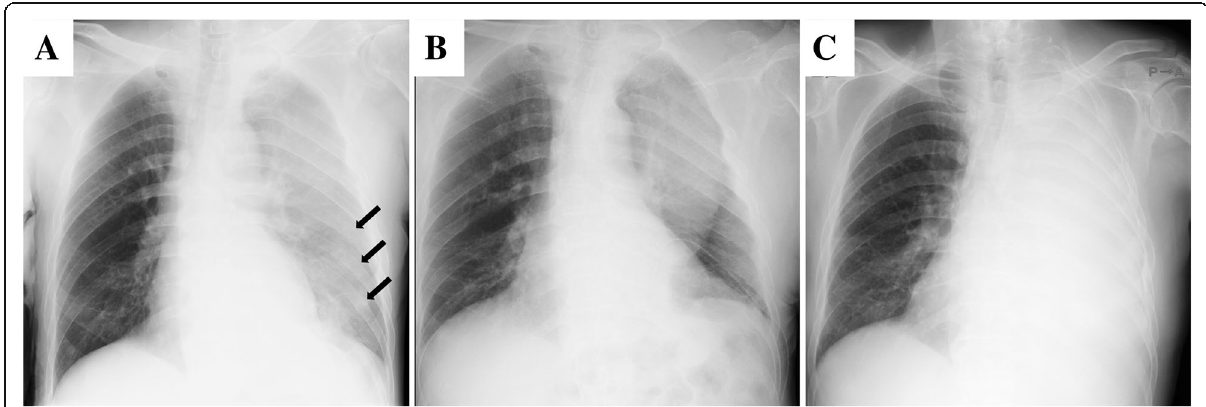
Fig. 1 Chest radiograph showing the left multiple rib fractures (black arrow), a hemothorax, and an extrapleural hematoma on admission ( a ); improved hemothorax with the residual extrapleural hematoma 5 days after the episode of trauma ( b ); and a large amount of pleural effusion 53 days after the episode of trauma ( c )